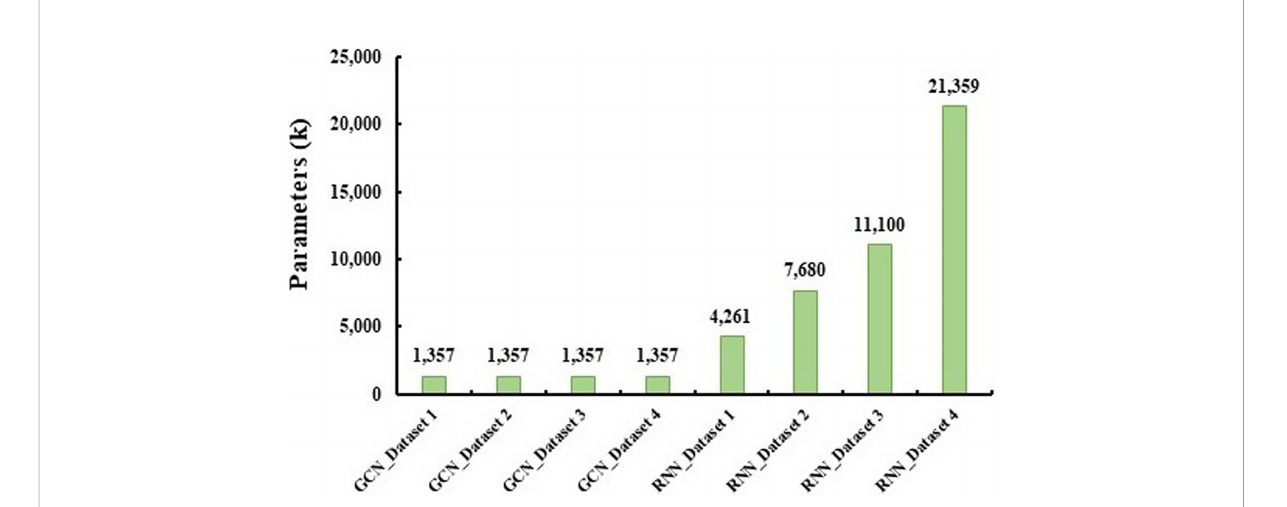
FIGURE 11 Space complexity of GCN-based and RNN-based methods on the different